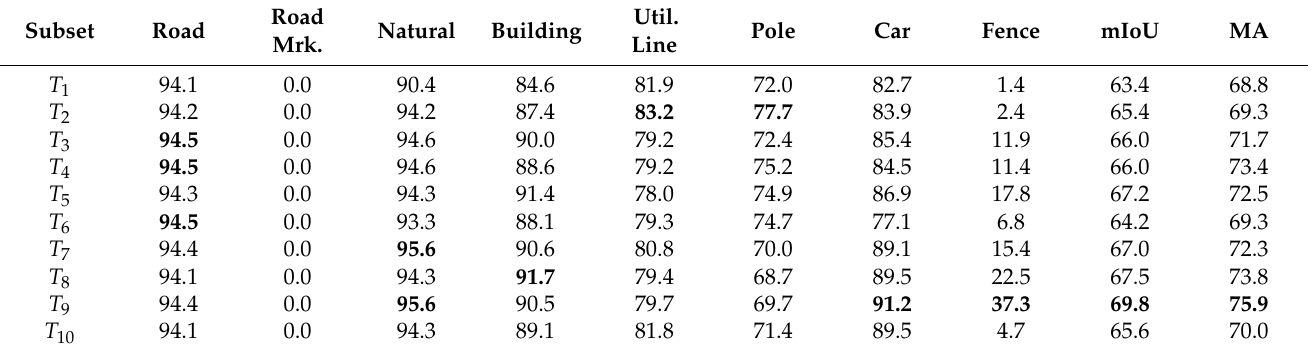
Table 2. Class-based results of SPG on subsets of Toronto3D. Highest values are marked in